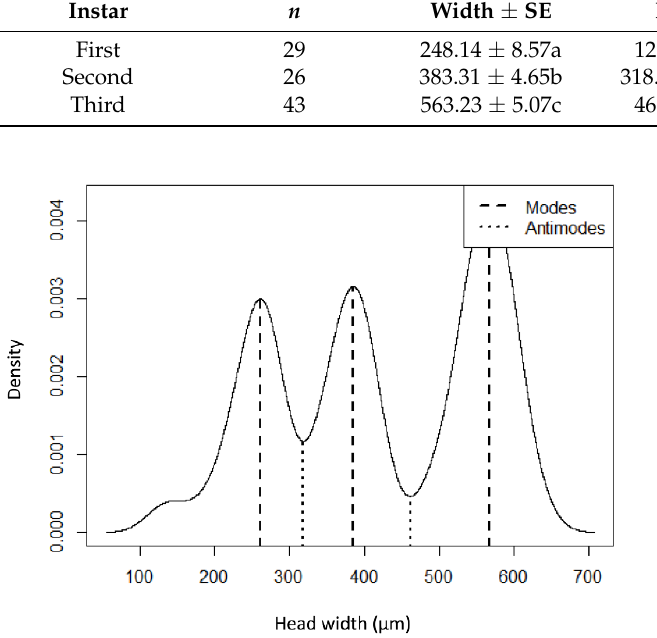
Table 1. Mean head capsule widths ( µ m) of larvae of the hibiscus bud weevil ( Anthonomus testaceosquamosus ) at 27 ± 1 °C, 60% RH and 12:12 h (L:D) photoperiod. Within each column, different letters indicate significant differences (Tukey, p < 0.05).